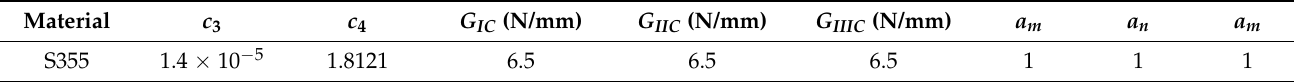
Figure 2. Paris’ law in terms of energy. Table 2. Material constants in Paris’ law and